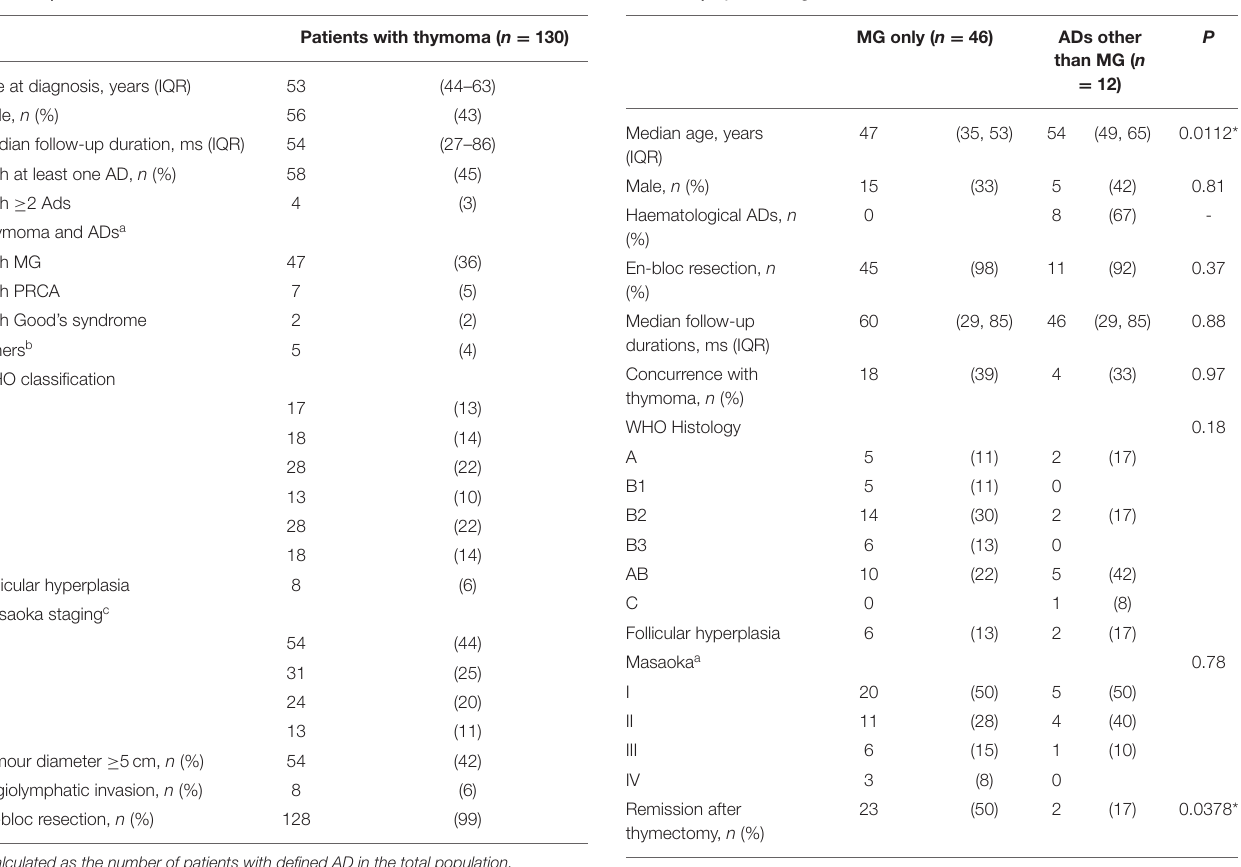
TABLE 1 | Patient characteristics. TABLE 2 | Myasthenia gravis vs. other autoimmune